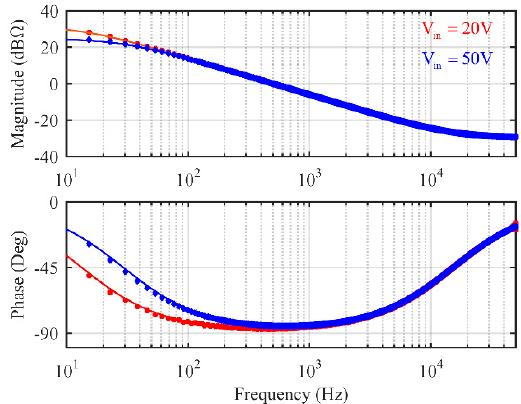
Figure 4. The predicted (solid lines) and simulated (diamond and square marks) frequency responses of the output impedance at the input voltages of 20 V (red) and 50 V (blue).